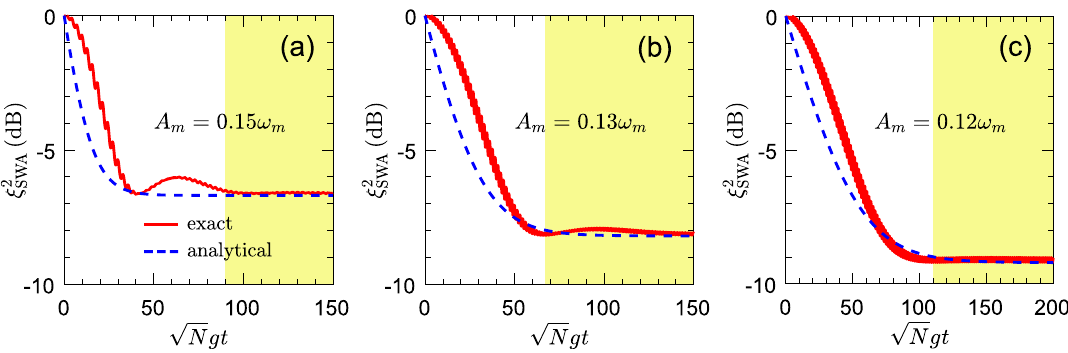
for (a) A m / ω m (cid:2) 0 . 15, (b) 0.13, and (c) 0.12. Solid curves are obtained from the full SWA (cid:7)(cid:7) √ N g (cid:2) 10 κ , and also that all atoms are initialized in the ground